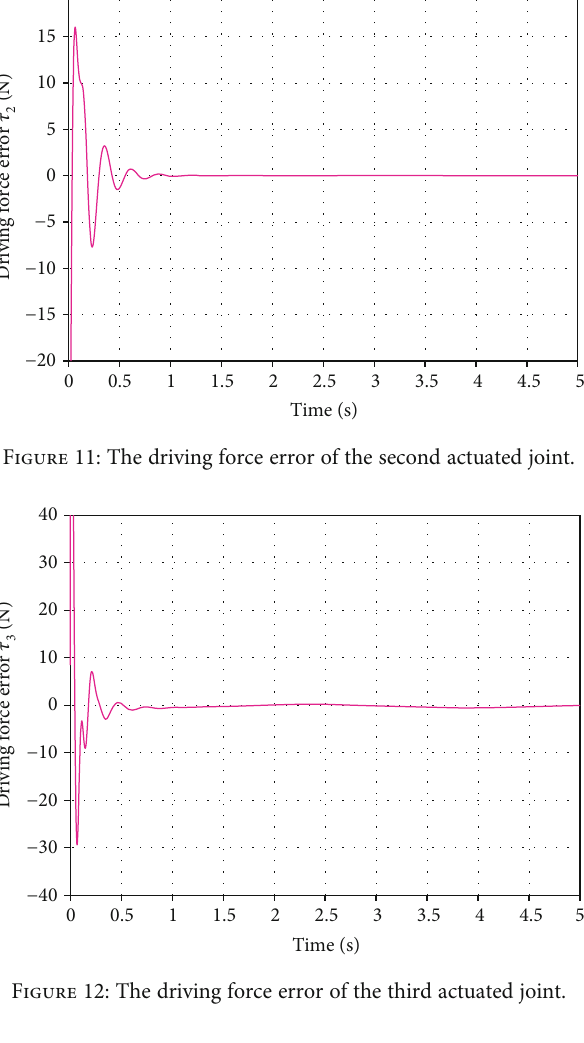
Figure 9: The position error of the fourth actuated joint d